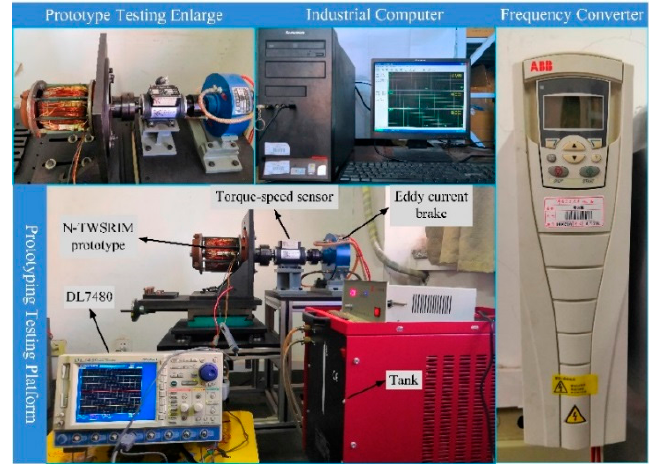
Figure 13. Prototype testing platform.